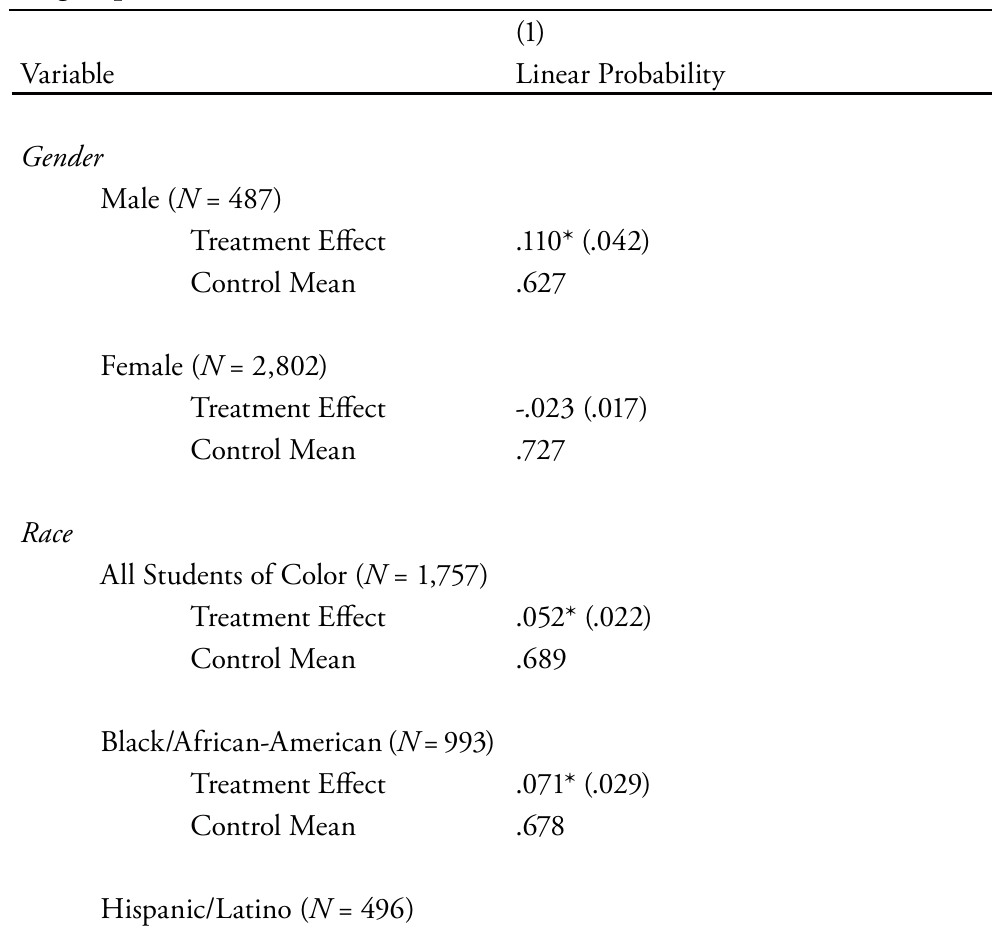
Table 4: Treatment Effects on Fall 2020 Reenrollment among Student